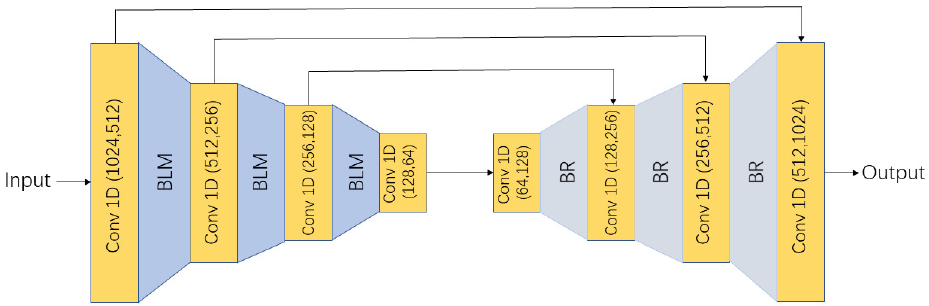
Figure 3. The architecture of residual backbone. BLM combines BachNorm, LeakyReLU and Max- Pooling layers. BR combines BachNorm and ReLU